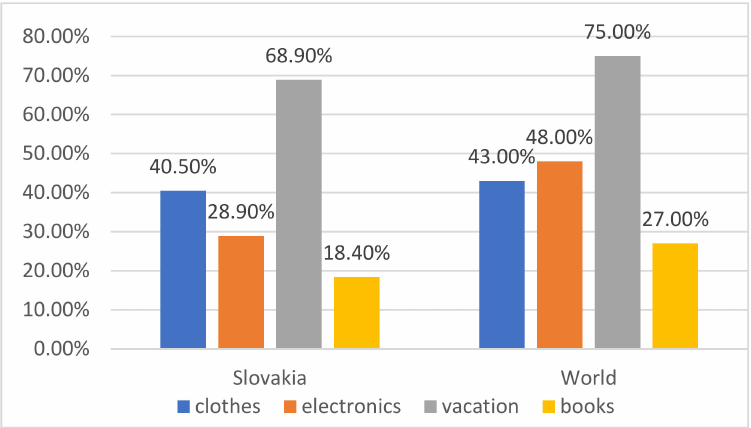
Figure 3. Illustration of increased purchases by product categories. Source: according to